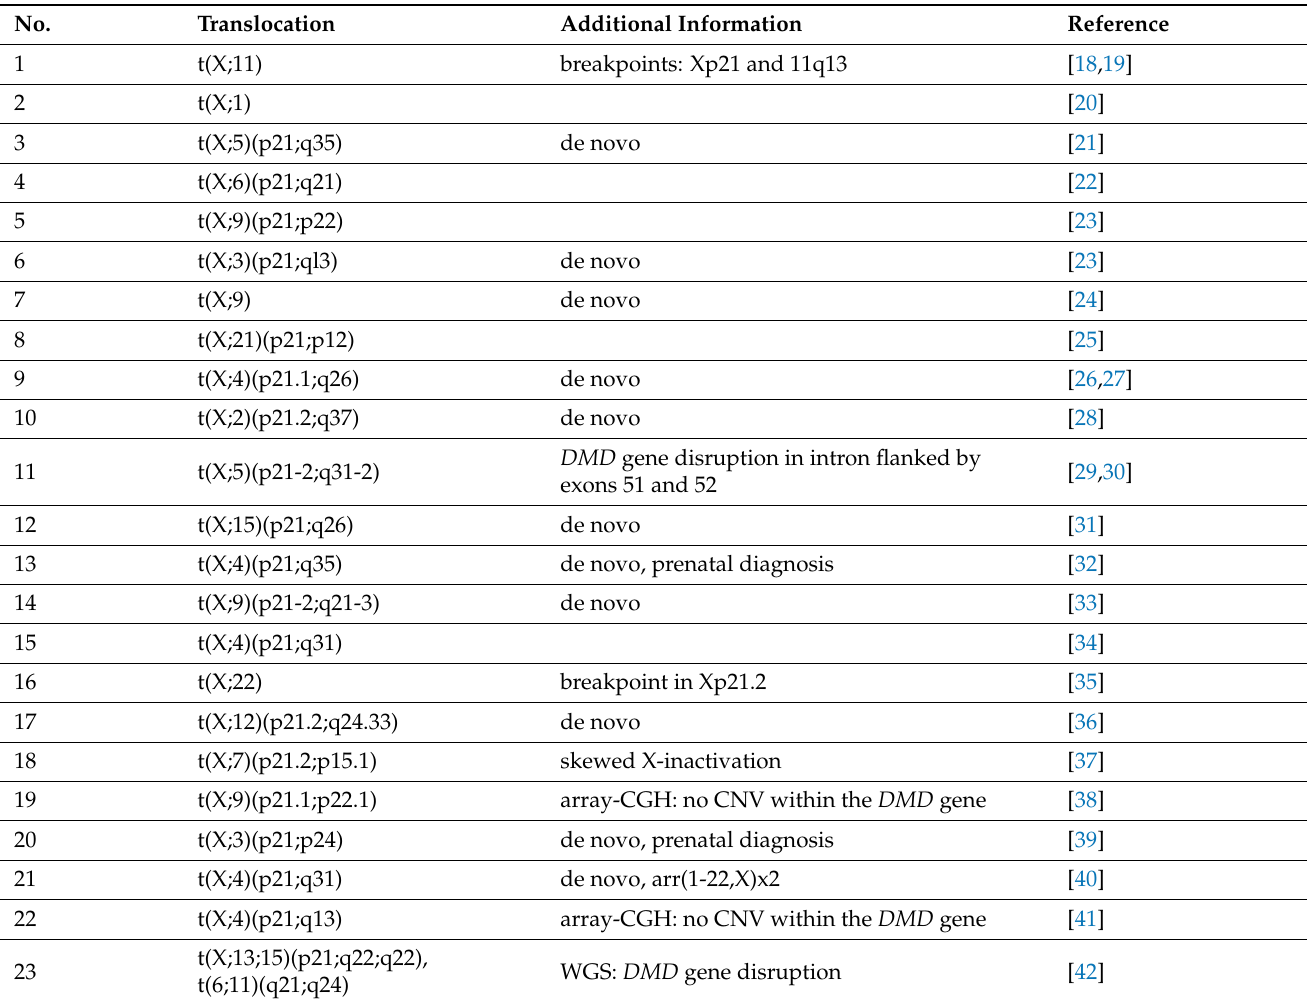
Table 1. Balanced translocations involving the DMD gene reported in the literature in females with DMD